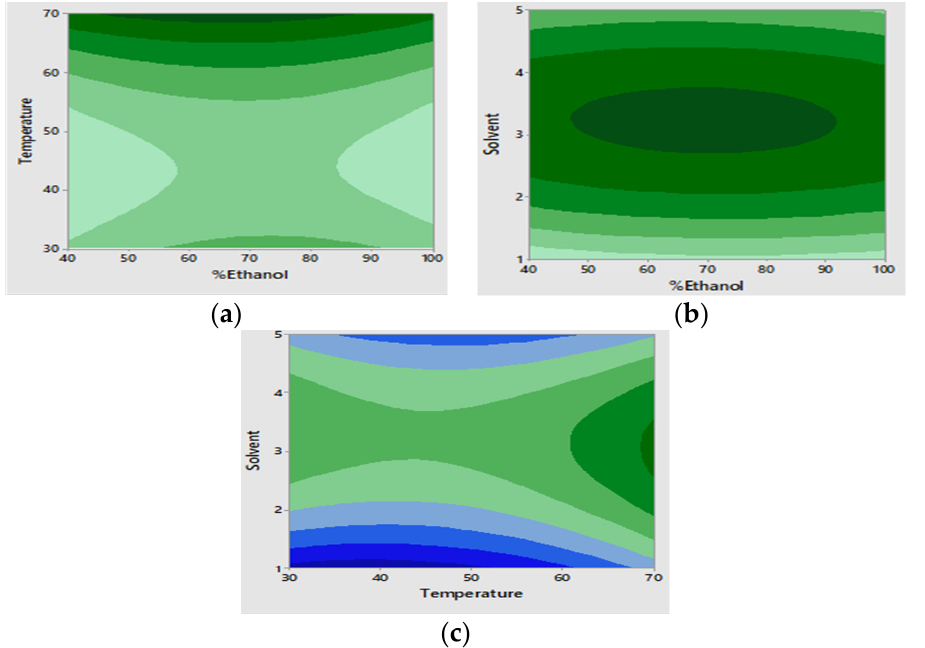
Figure 3. Surface and contour plots showing percentage recovery as function of the effects temperature and solvent ratio while keeping percentage ethanol constant ( a ); effects of percentage ethanol and solvent ratio while keeping temperature constant ( b ); and effects of percentage ethanol and temperature while keeping solvent ratio constant ( c ).